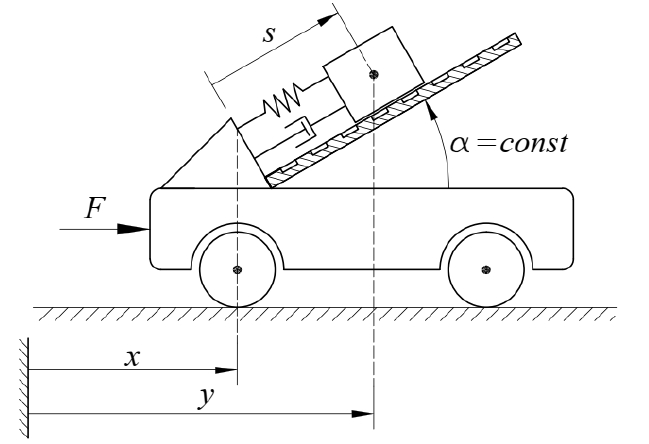
Figure 12. Mass on car